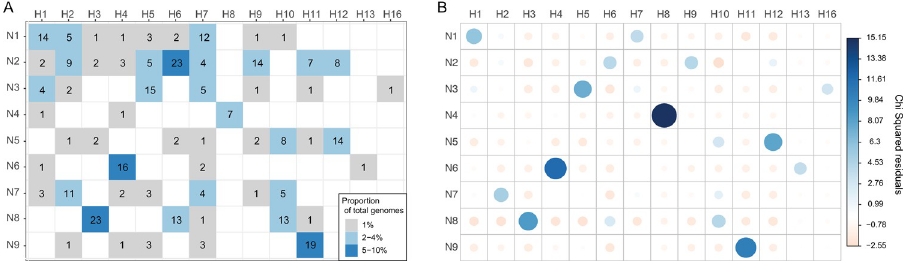
Fig 2. HA-NA subtype linkage in data generated for this study. (A) The number of each HA-NA subtype combinations (values) and the proportion of the total data set these values represent (shading). (B) A plot of the Pearson residuals of Chi-squared tests. For a given cell, the size of the circle is proportional to the amount of the cell contribution. Positive residuals are in blue and identify HA and NA subtypes for which there is a strong positive association in the data set. Negative residuals are in light pink and show a weak negative association, that is, they are underrepresented in the data set. This figure comprises unique viral genomes with at least one segment. Plots of subtype data by location and time are presented in S3